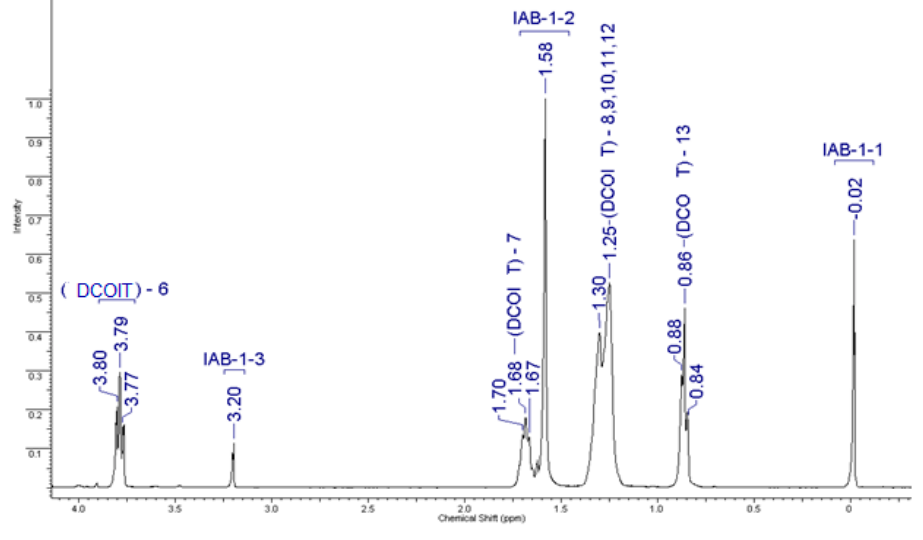
Figure 11. 1 H NMR spectra of SMCs with DCOIT.